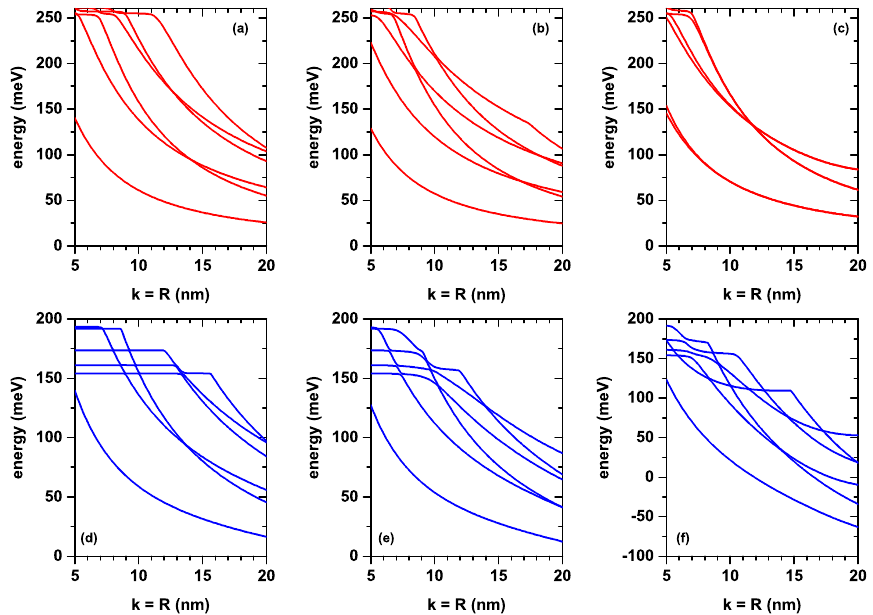
Figure 4. The lowest six energies for a confined electron within the CQD as a function of the si- multaneous variation of the k -width in the axial direction and the R -radius in the radial direction. Calculations are for zero ( a – c ) and F = 50kV/cm ( d – f ) with l = 0. The results are reported for the three considered axial finite confinement potentials: V 2 ( z ) ( a , d ), V 3 ( z ) ( b , e ) and V 4 ( z ) ( c , f